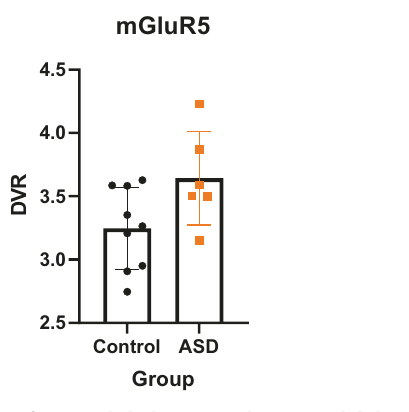
Fig. 2 Comparison of striatal/thalamic Glx (Glutamate and Glutamine) and GABA + complex (GABA + macromolecules) in the ASD and control groups. The control group is represented in black and the ASD (Autism Spectrum Disorder) group is represented in orange. Error bars represent one standard deviation.